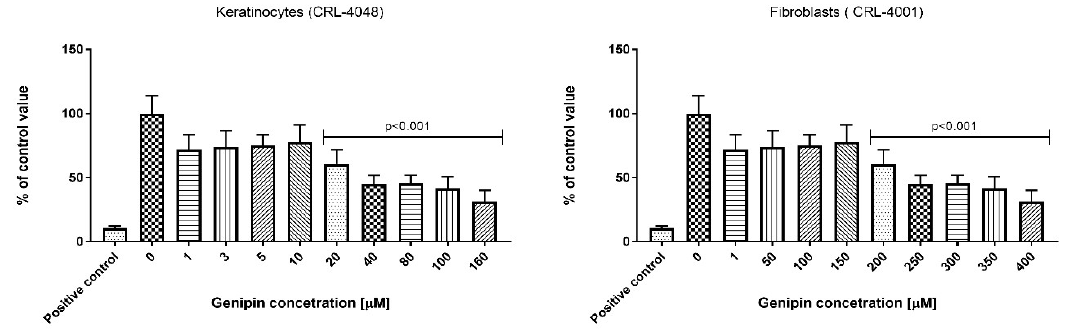
Figure 1. E ff ect of genipin on keratinocytes and fibroblasts. The cytotoxic e ff ect was measured by MTT Figure 1. Effect of genipin on keratinocytes and fibroblasts. The cytotoxic effect was measured by test according to ISO 10993-5 MTT test according to ISO 10993-5 protocol.